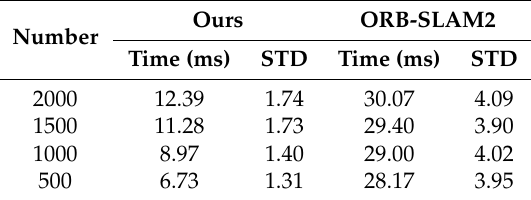
Figure 7. The effect of different numbers of expected feature points on the efficiency of two feature extraction algorithms. Table 1. Comparison of extraction times.